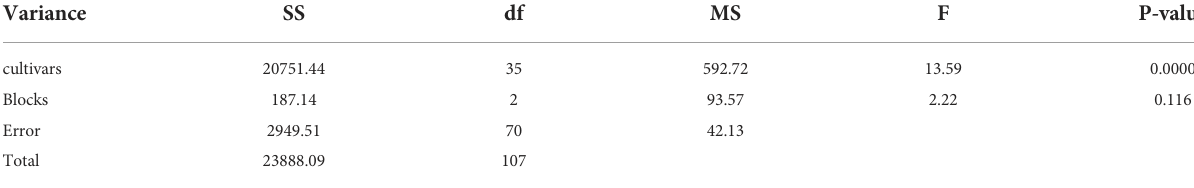
TABLE 2 Anaylsis of Variance (ANOVA) used to evaluate the signi fi cance differences in 36 cultivars resistance to the Berkeleyomyces rouxiae. Variance SS df MS F P-value